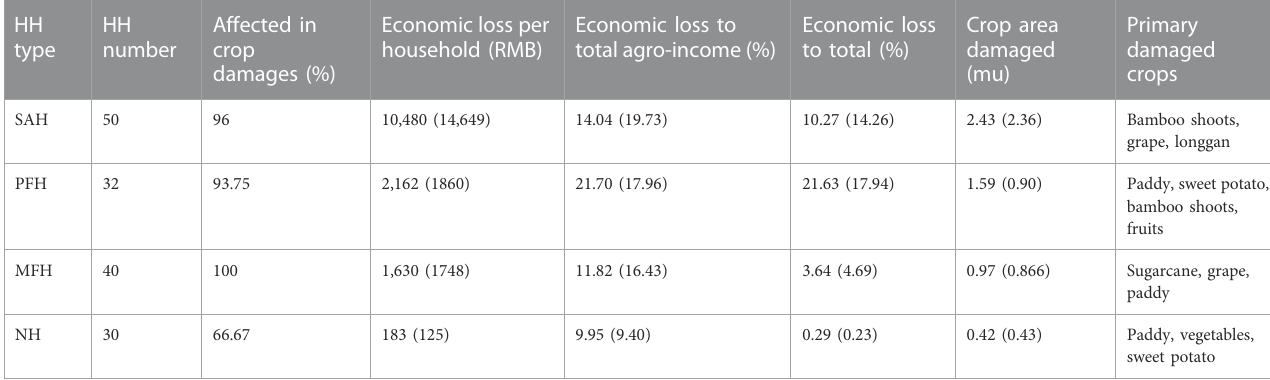
TABLE 4 Crop damages and economic losses caused by wild boars for different rural